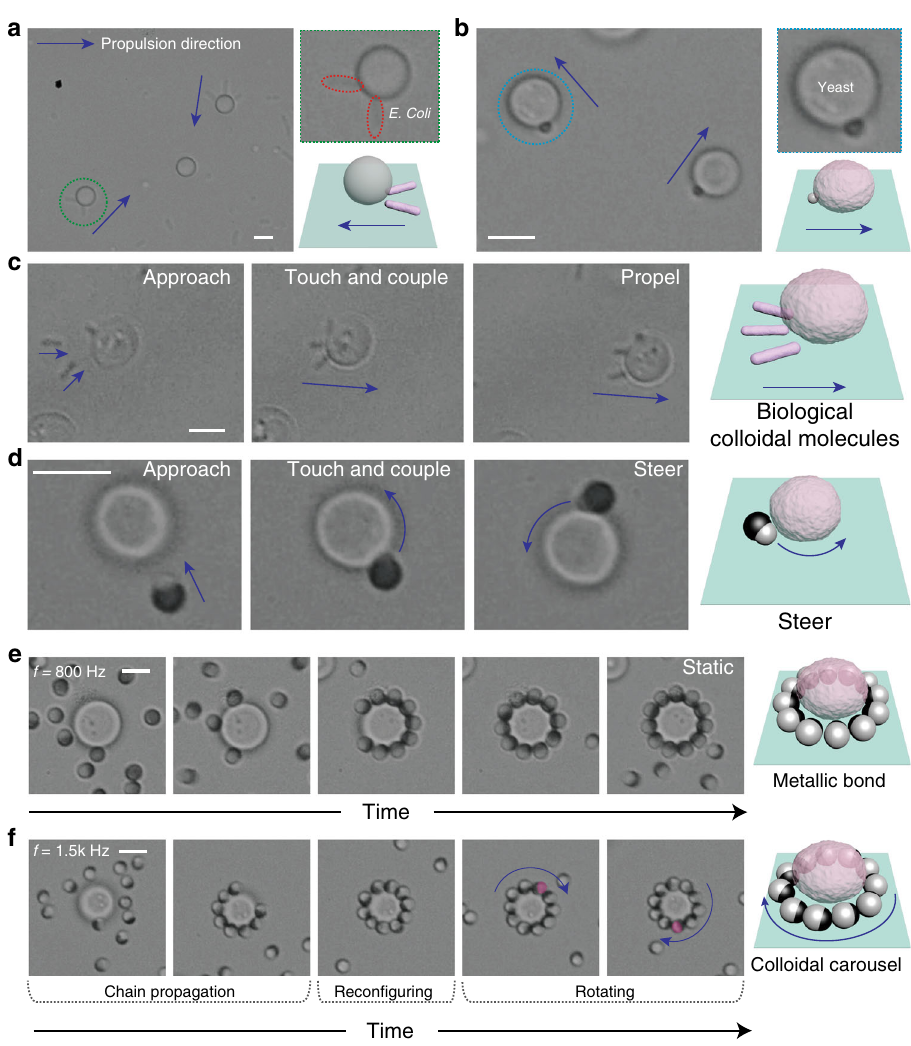
Fig. 6 Hybrid colloidal molecules by living cells and synthetic particles. a Self-propelled colloidal molecules assembled by E. coli and dielectric sphere ( D = 4 μ m). b Self-propelled colloidal molecules by yeast cells and dielectric sphere ( d = 1 μ m). c Yeast cell and E. coli assemble to form purely biological colloidal molecules, which propels under the EHD mechanism. d Yeast cell and P 1 assemble to form steering colloidal molecules following an approach- touch-steer assembly process. e Time lapses showing the formation of colloidal molecules with metallic bond by patchy particle P 4 and yeast cell ( f = 800 Hz). f P 4 and yeast cells assemble into a colloidal carrousel when propulsion directions of patchy particle synchronize ( f = 1500 Hz). Scale bar: 4 μ